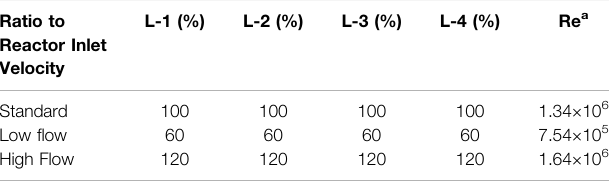
TABLE 4 | Test requirements and balanced conditions for the inlet fl ow.